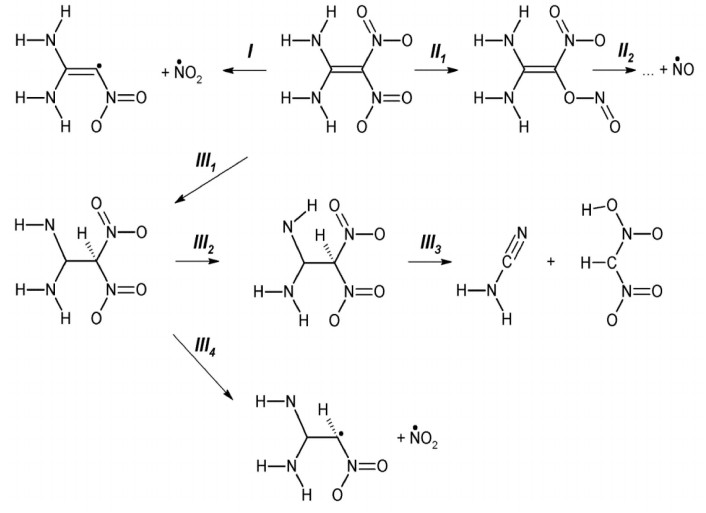
Figure 9. A schematic representation of DADNE fragmentation